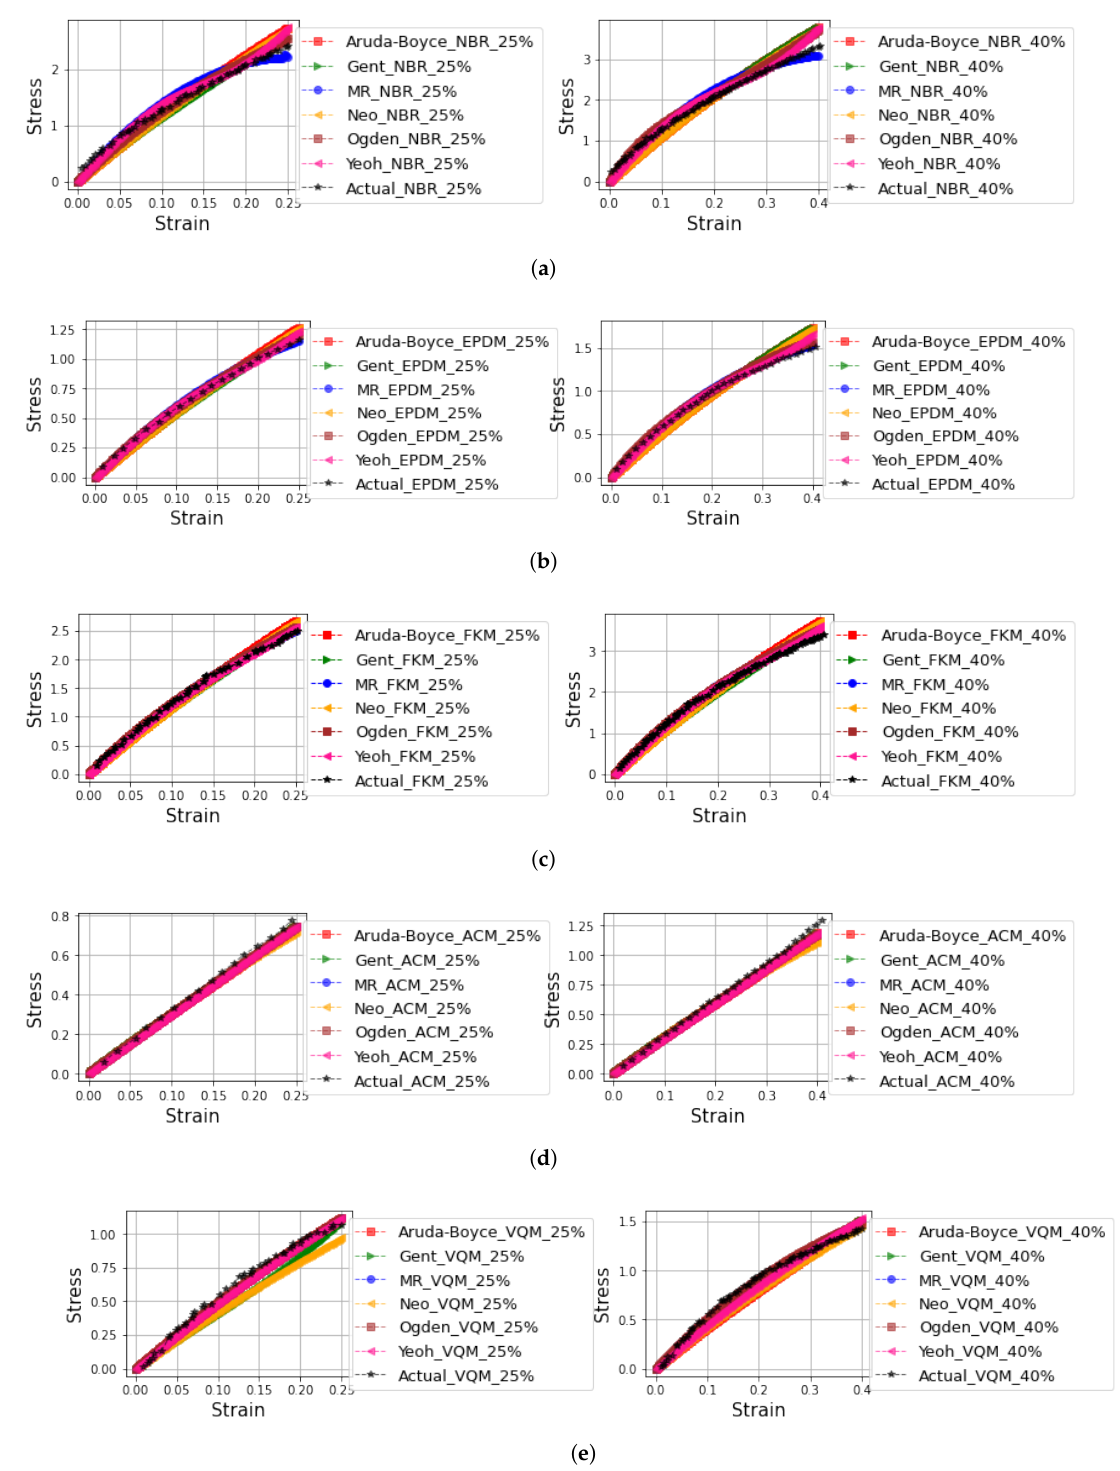
Figure 5. Stress–strain outputs from the hyperelastic models for the materials at 25% and 40% displacement ( a ) NBR, ( b ) EPDM, ( c ) FKM, ( d ) ACM, and ( e )